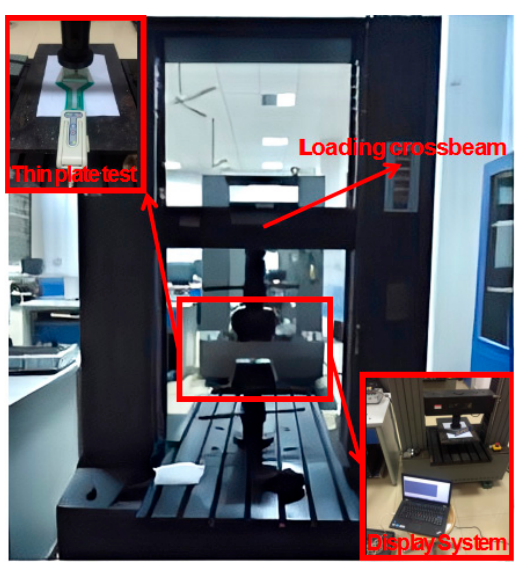
Figure 3. The schematic diagram of the test assembly.